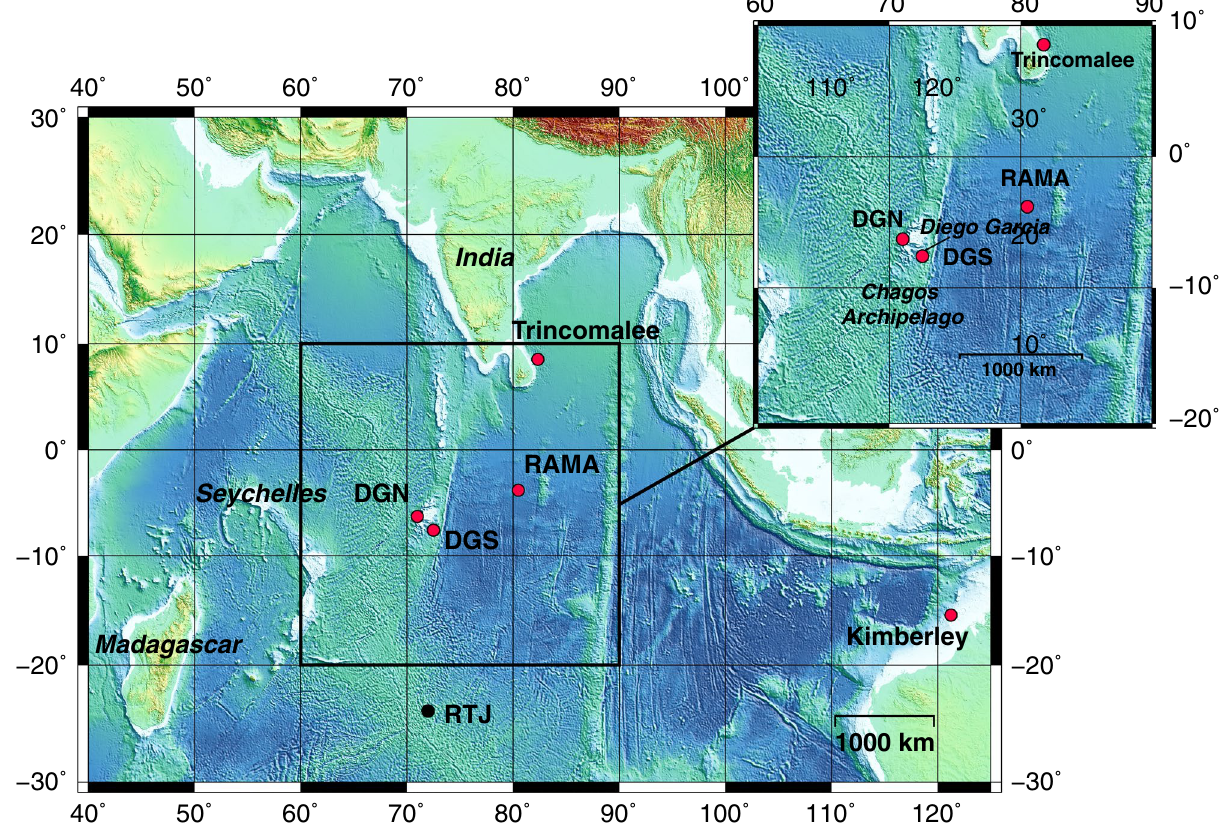
Figure 2. Study area and locations of the hydroacoustic stations (circles) used in this study to explore the presence of Chagos songs: in the equatorial waters, off Trincomalee, Sri Lanka; in the tropical waters: RAMA and the western (DGN) and eastern (DGS) sides of Chagos Archipelago; Kimberley, at the north of Western Australia, at the limit between the tropical and subtropical waters; and RTJ in the subtropical waters of the central Indian Ocean. Red circles indicate the sites where Chagos songs have been